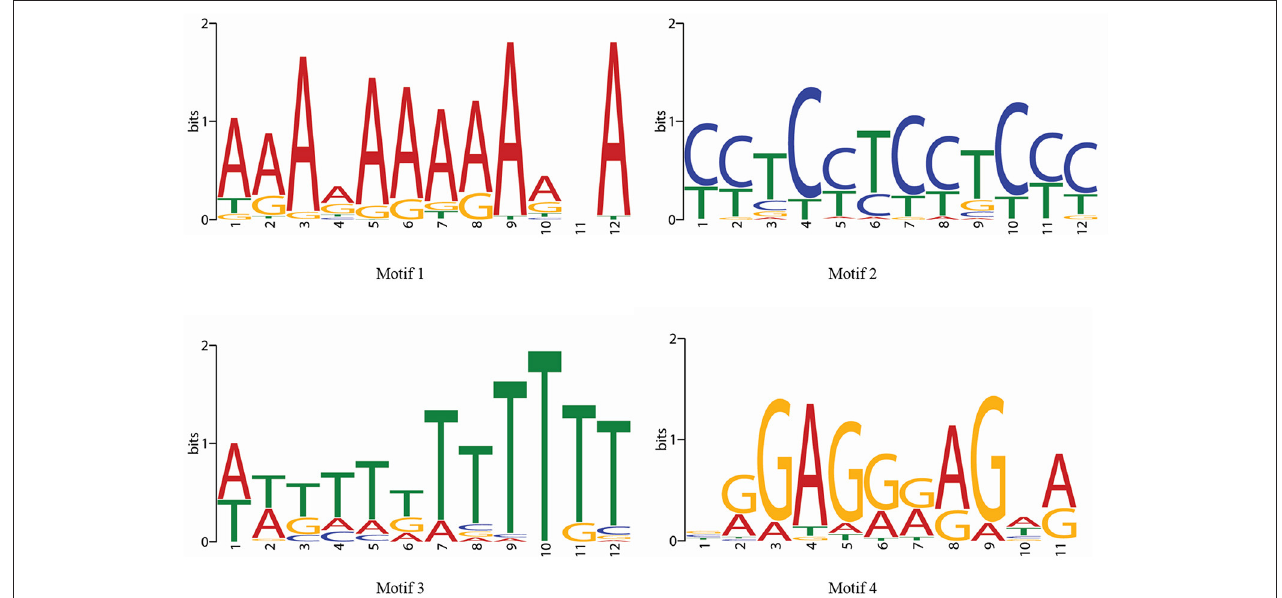
FIGURE 7 | Four enriched motifs logo in the 1kb promoter region of first neighboring target genes of guide OsMYBs in the co-regulatory